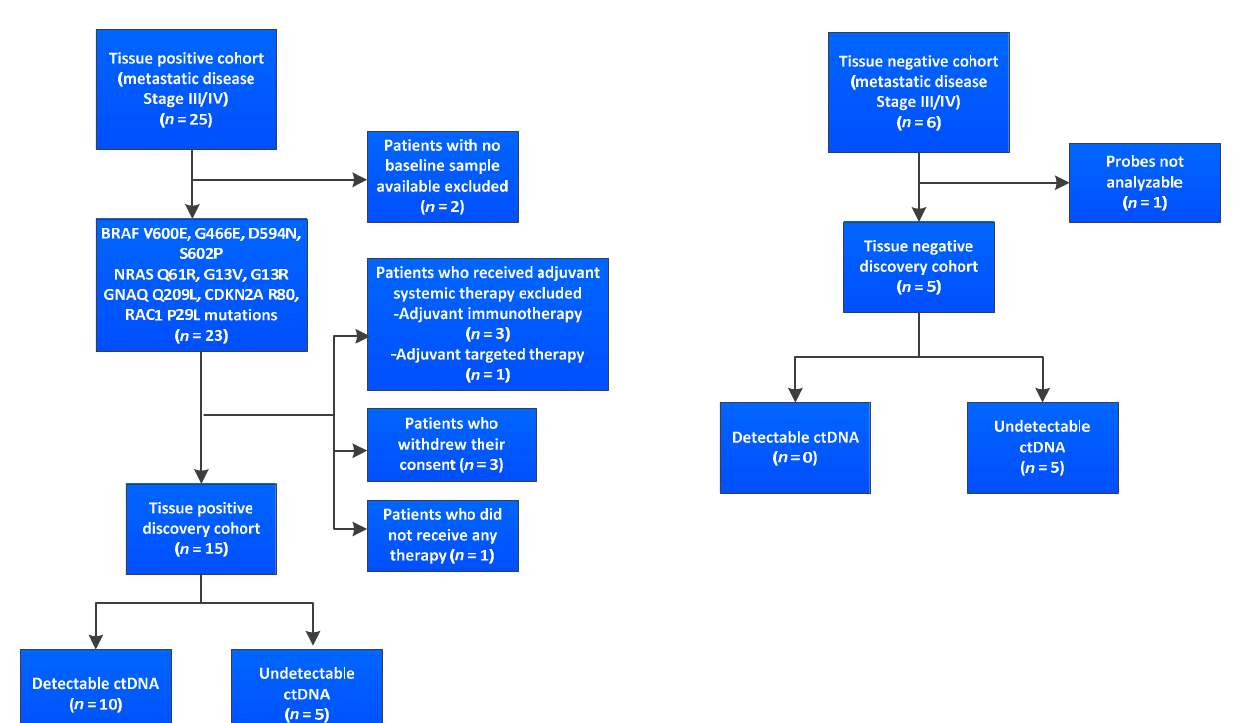
Figure 1. Flowchart showing total number of patients recruited for study and reasons for exclusion from further evaluation and ctDNA analysis. The type of mutations in tissue positive cohort are at baseline (pretreatment). Tissue positive cohort included patients with at least one melanoma-associated mutation in tissue specimen. Tissue negative cohort consisted of patients without a mutation in tissue specimen. ctDNA: circulating tumor DNA. Table 1. Baseline patient characteristics of cohort ( n =